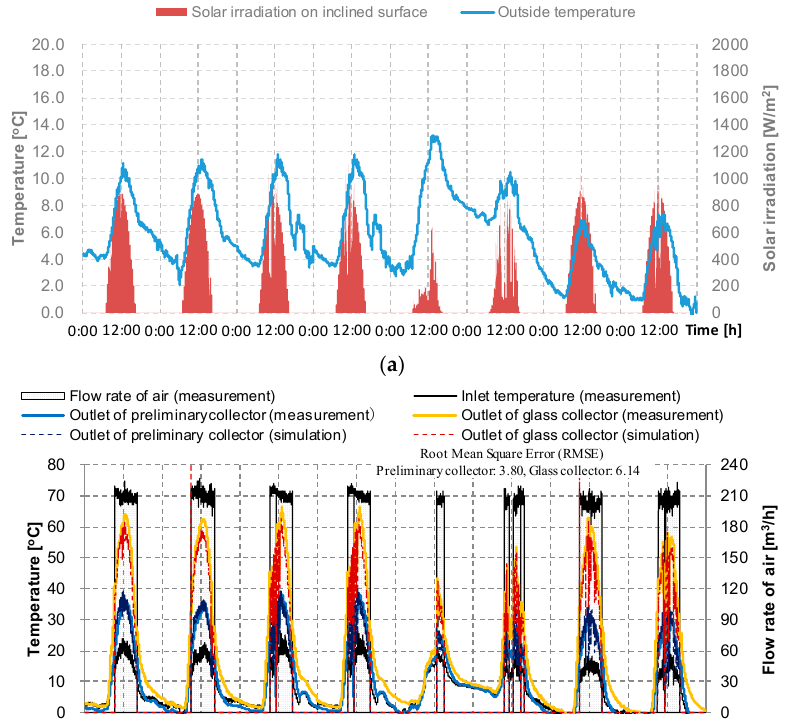
Figure 4. Target collector. Reproduced from [20], publisher: 2018.